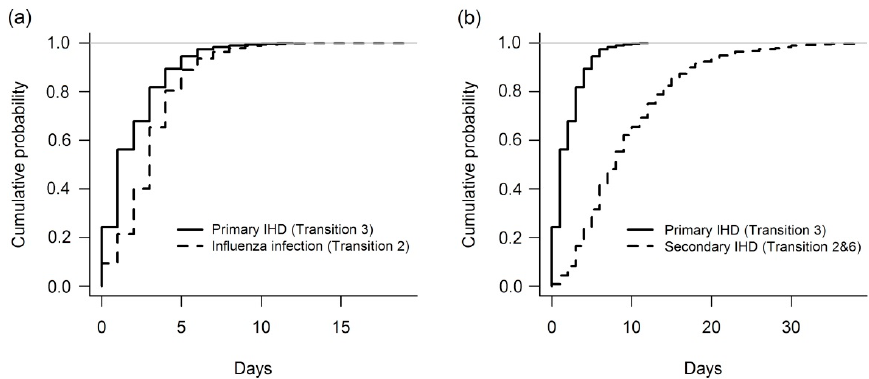
Figure 3. Cumulative probability plots of IHD incidence and influenza infections. Cumulative probability plots of ( a ) primary IHD incidence and influenza infections; and ( b ) primary and secondary IHD incidence. Results shown for a single randomly selected simulation.